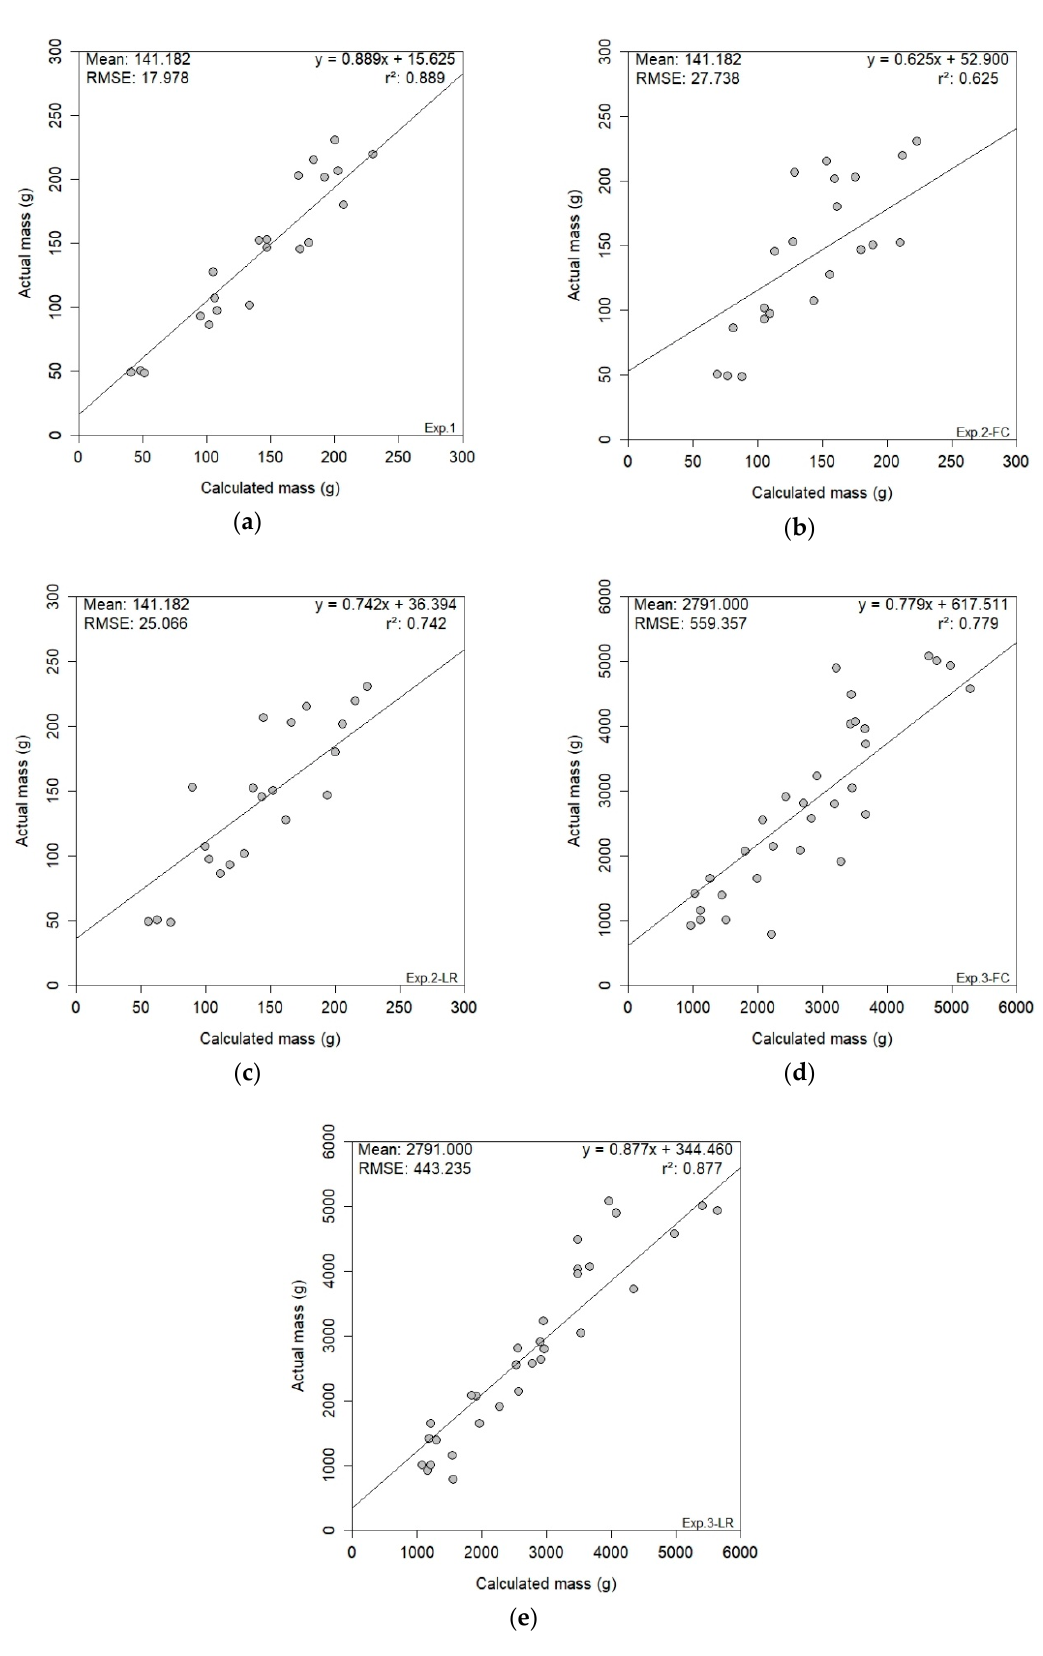
Figure 12. RGB results presented for the three experiments; experiment one ( a ), experiment two FC ( b ) & LR ( c ) and experiment three FC ( d ) & LR ( e ). {Key: Exp. = experiment; FC = full canopy; LR = leaf removal.}.